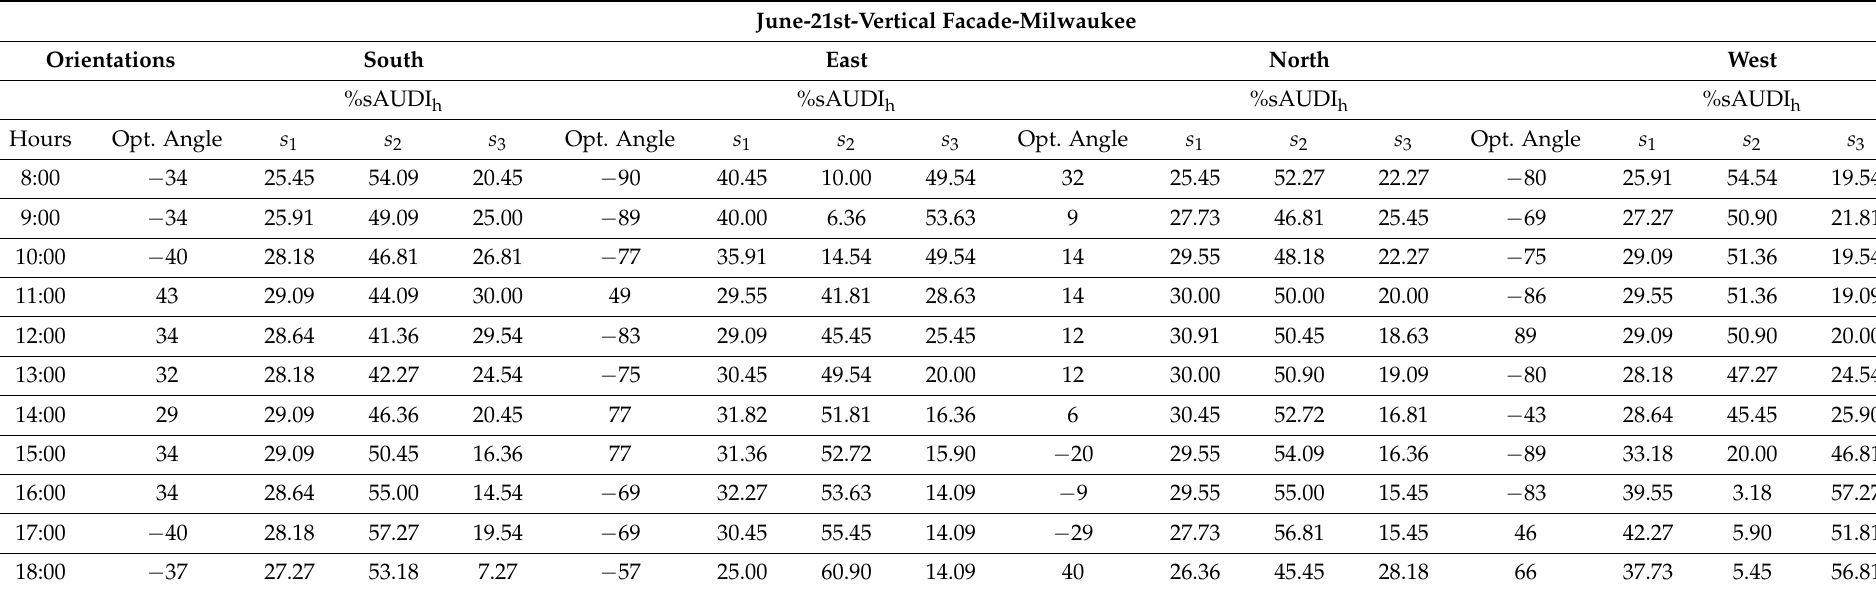
Table 11. The hourly optimum angles and their associated %sAUDI h on 21 June in Milwaukee − Vertical